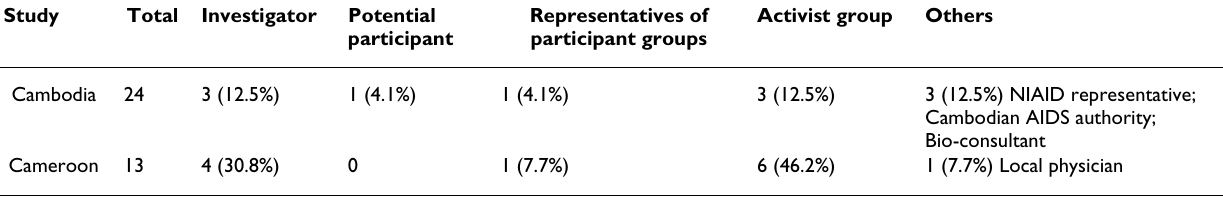
Table 2: Sources of information cited in media reports